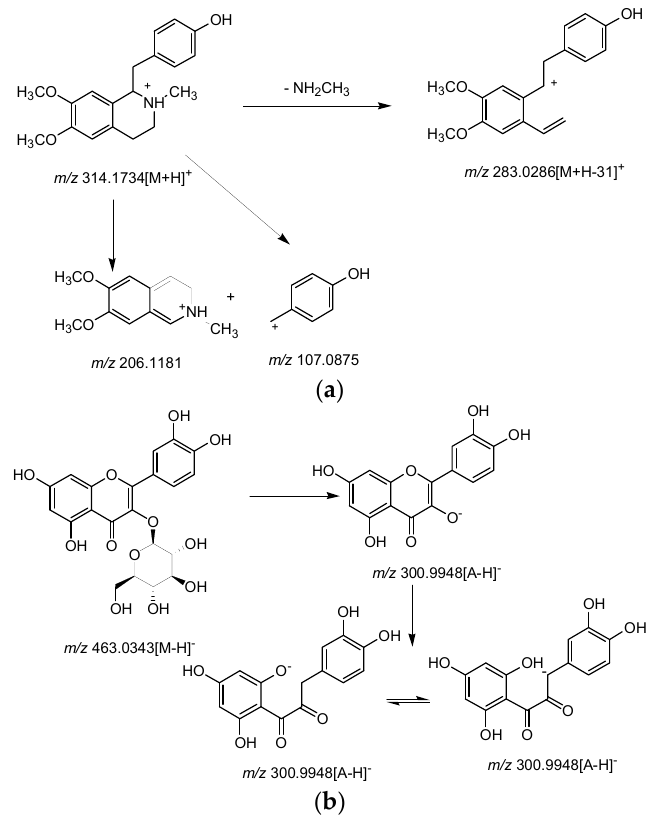
Figure 4. The possible fragment pathway for peak 17 and 56 .